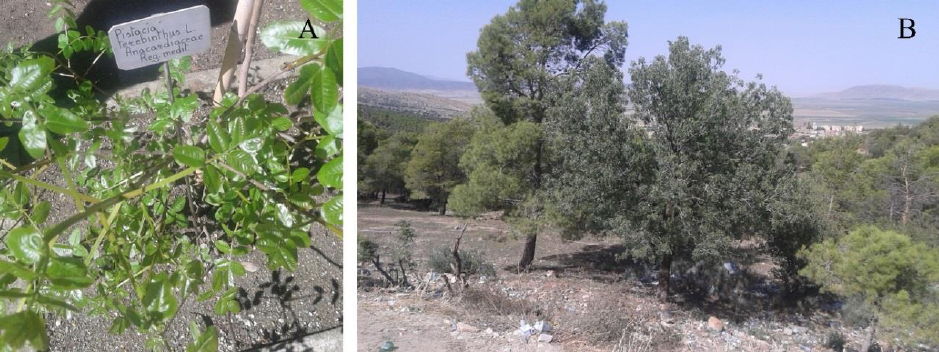
Figure 1. Pistachio Terebinth tree of Botanical Garden in Padova (Italy) ( A ); Atlas pistachio tree in region of Batna (Algeria) ( B ). Photos: Labdelli A.